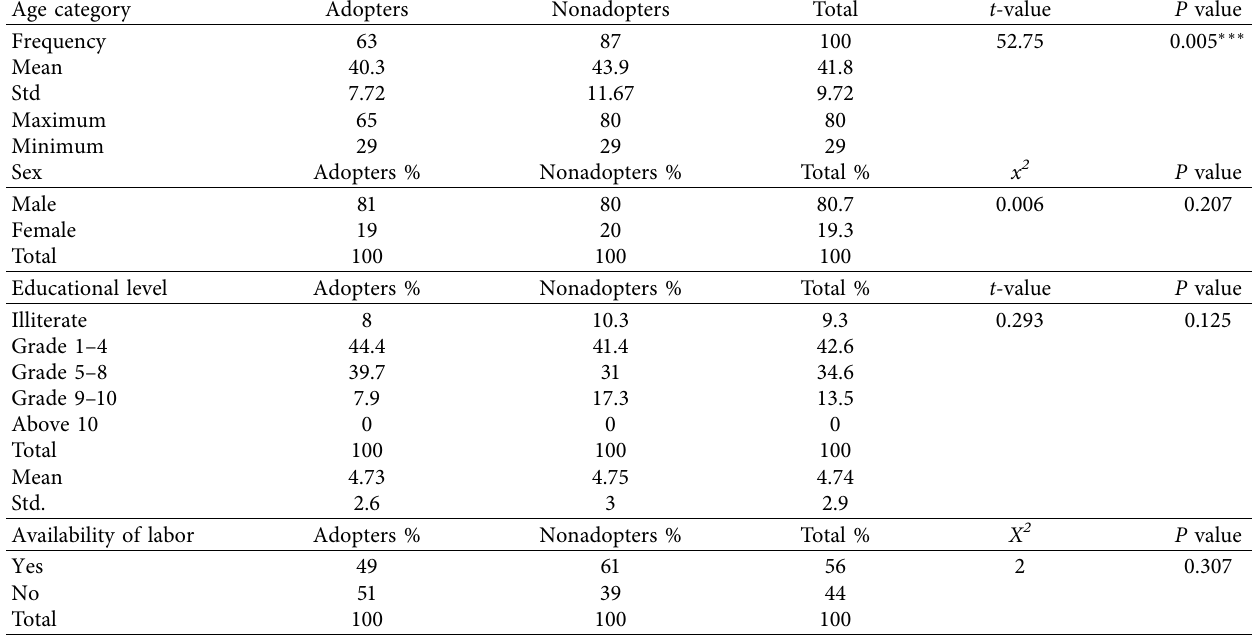
Table 3: Demographic